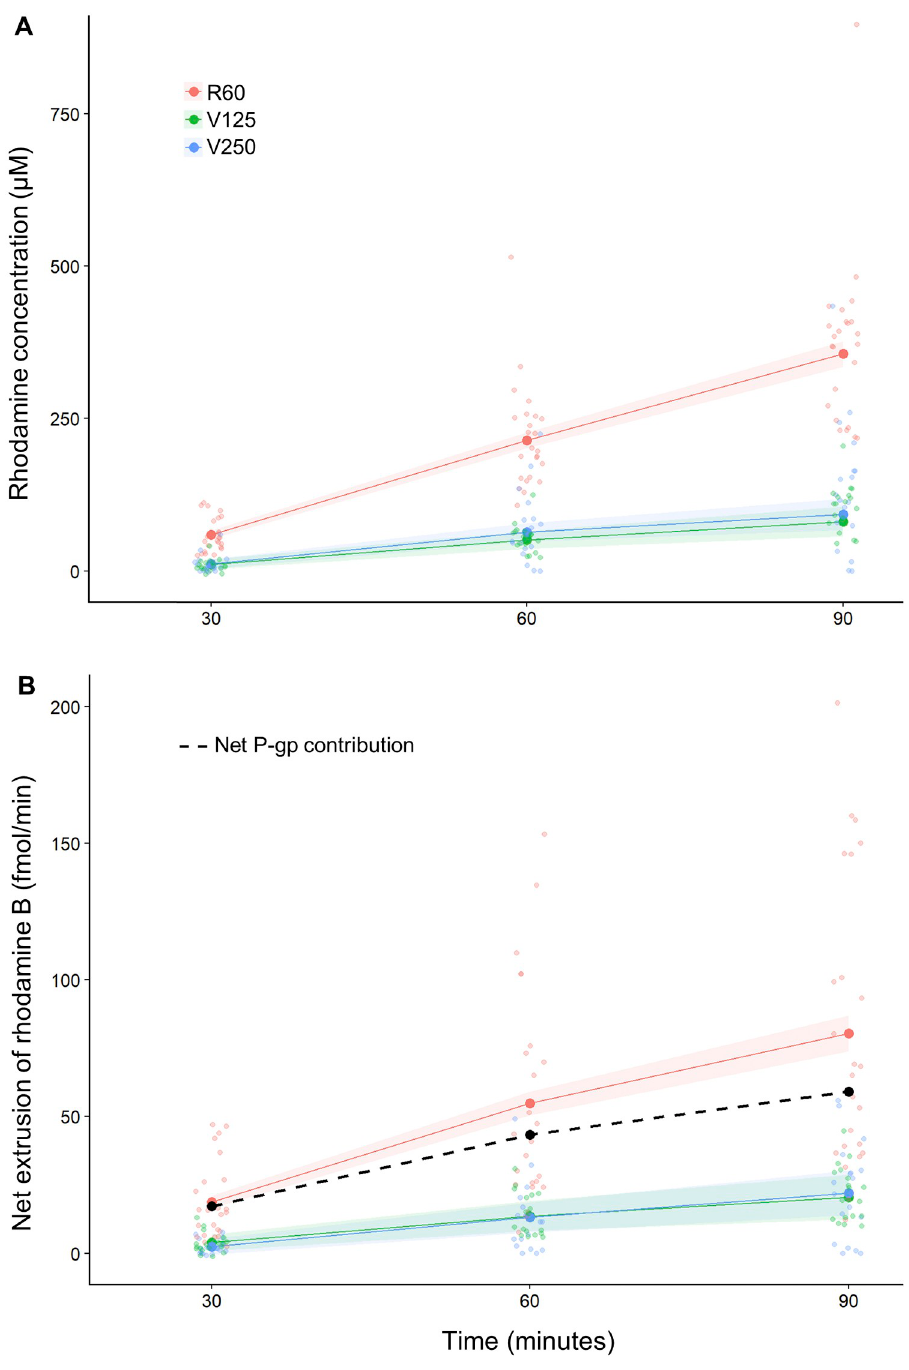
Fig 4. The mean rhodamine B concentration of the droplets secreted by the Malpighian tubules, and the mean net extrusion of rhodamine B increased over time in all the treatments. ( A ) The addition of verapamil (125 or 250 μ M) reduced the rhodamine B concentration of the droplets secreted compared with the control treatment 60 μ M rhodamine. ( B ) The addition of verapamil (125 μ M or 250 μ M) reduced the net extrusion of rhodamine B compared with the control treatment 60 μ M rhodamine. The dashed line represents the net contribution of the P-glycoproteins obtained by subtracting the net extrusion of rhodamine in the V250 treatment from the R60. Each line with shaded region represents the mixed effect model fit with the standard error. Small circles represent the raw